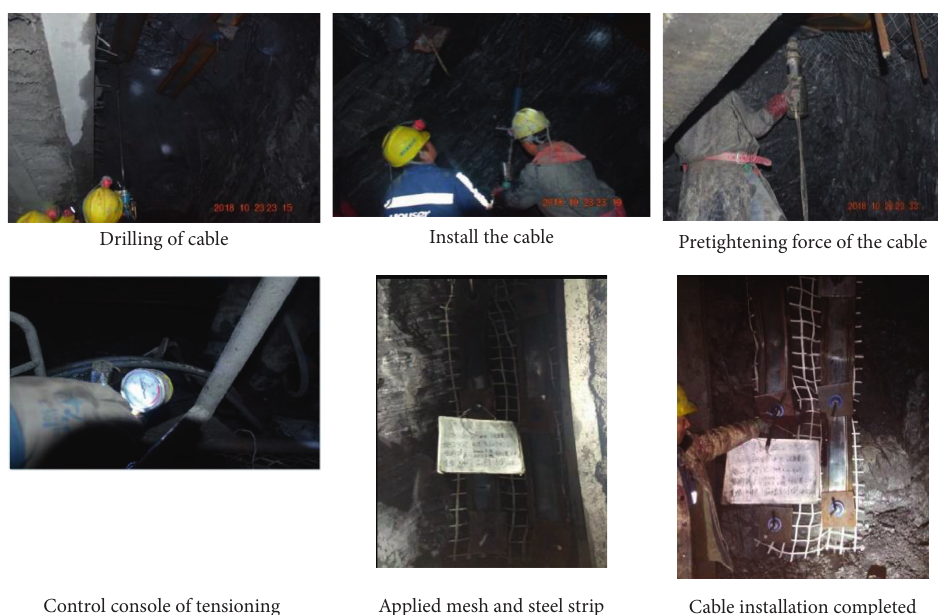
Figure 15: Pretension cable-mesh installation process.